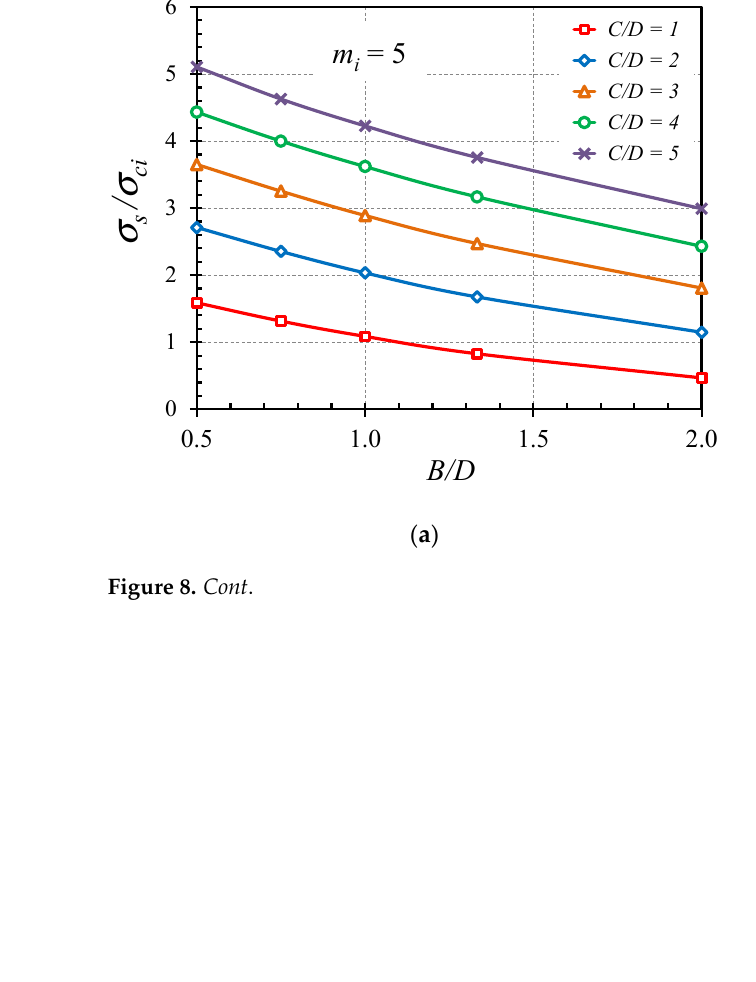
( b ) Figure 8. Impact of B / D on σ s / σ ci of horseshoe tunnels with σ ci / γ D = 1000 and GSI = 80: ( a ) m i = 5 and ( b ) m i = 30. 5.3. Failure Mechanisms The final adaptive meshes using the 5th iteration for the three B / D = 0.5, 1, and 2 are shown in Figure 9, while the plots of the shear dissipations indicating the failure zones of the three B / D are presented Figure 10. These plots are based on the case of ( σ ci / γ D = 1000, GSI = 80, and m i = 20). It is interesting to note that either the final adaptive meshes or the shear dissipation plots are adapted to represent the plastic shear zone of the horseshoe tunnels in rock masses. Note that the zones with the adaptive mesh refinement can be used to represent the same zones of the shear dissipation since the patterns of both are in the similar manner. The failure zone frequently displayed an oval form and spans from the tunnel’s base to the rock’s surface. The size of the failure zone around the tunnel is reduced by a greater B / D . The failure zone for the case with B / D = 2.0 extends from the corner point of the tunnel, while the failure zone for the case with B / D = 0.5 extends from below the base of tunnel.